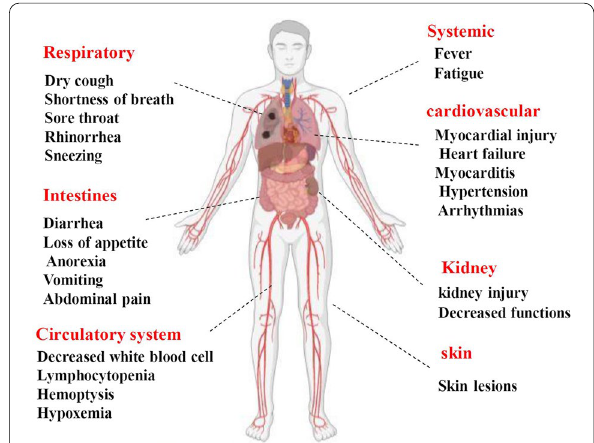
Fig. 3 The systemic and respiratory manifestations of SARS-COV-2